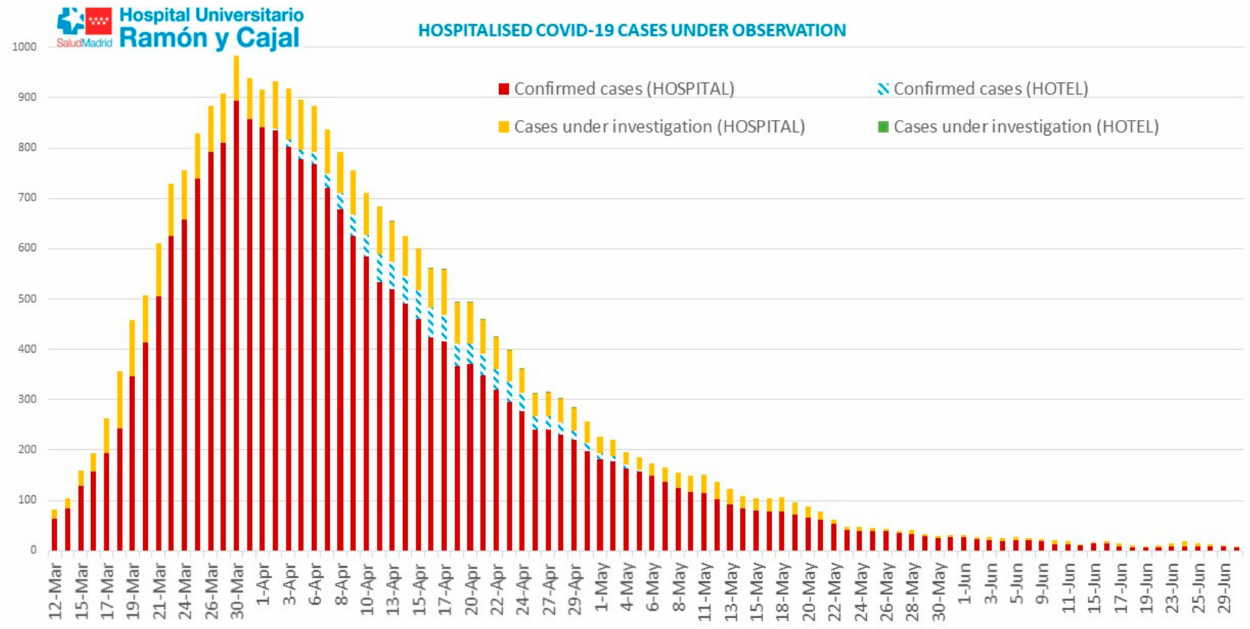
Figure 1. SARS-CoV-2 epidemic curve in